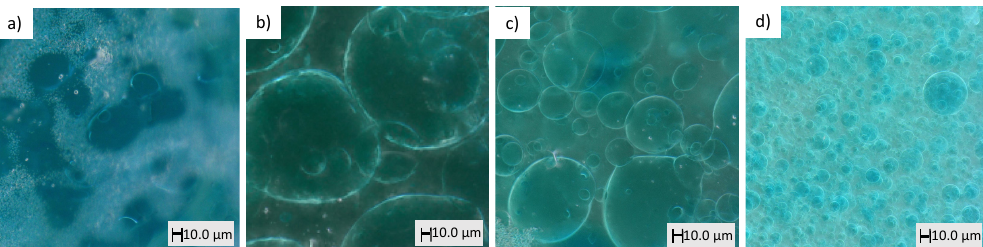
Figure 6. Representative DOM images of Pc PAL-PAL precursor mixtures ( a ) without emulsifier, and Pc PAL-PAL precursor mixtures with various emulsifiers (0.1 M): ( b ) Tween 80, ( c ) Birj 20, and ( d ) Span 40.